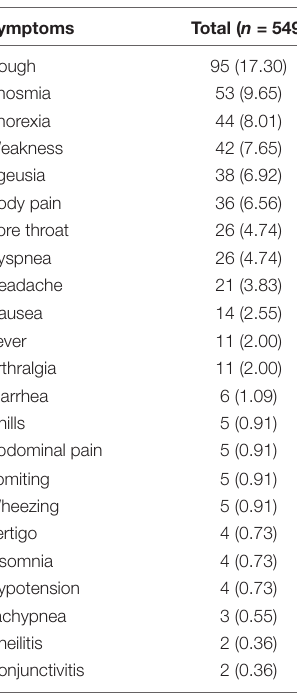
TABLE 8 | Symptoms of outpatients on the seventh day of